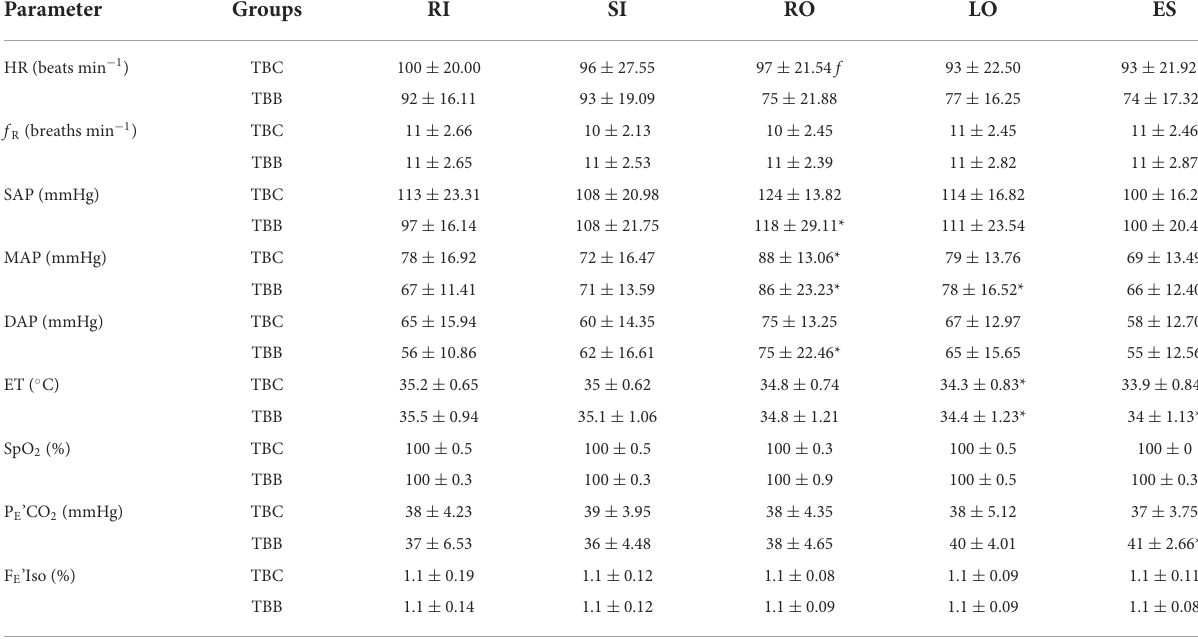
TABLE 1 Mean ± standard deviation of heart rate (HR), respiratory rate ( f R ), systolic arterial pressure (SAP), mean arterial pressure (MAP), diastolic arterial pressure (DAP), esophageal temperature (ET), peripheral oxygen saturation (SpO 2 ), end-tidal carbon dioxide concentration (P E ’CO 2 ), and end-tidal isoflurane concentration (F E ’Iso) in dogs during ovariohysterectomy. Parameter